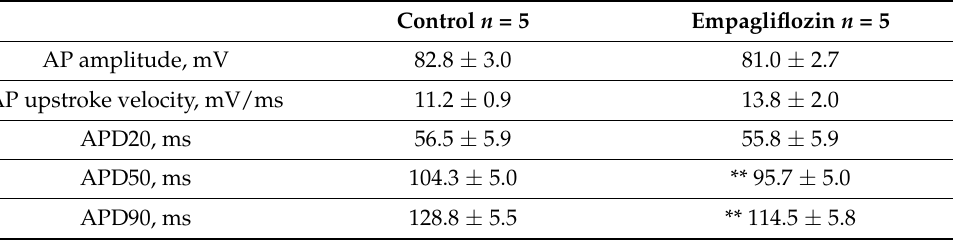
Table 2. Amplitude and time parameters of the AP in ventricular myocardium of isolated zebrafish heart. Values are represented as mean ± SEM. ** p < 0.01 obtained by paired Student’s t